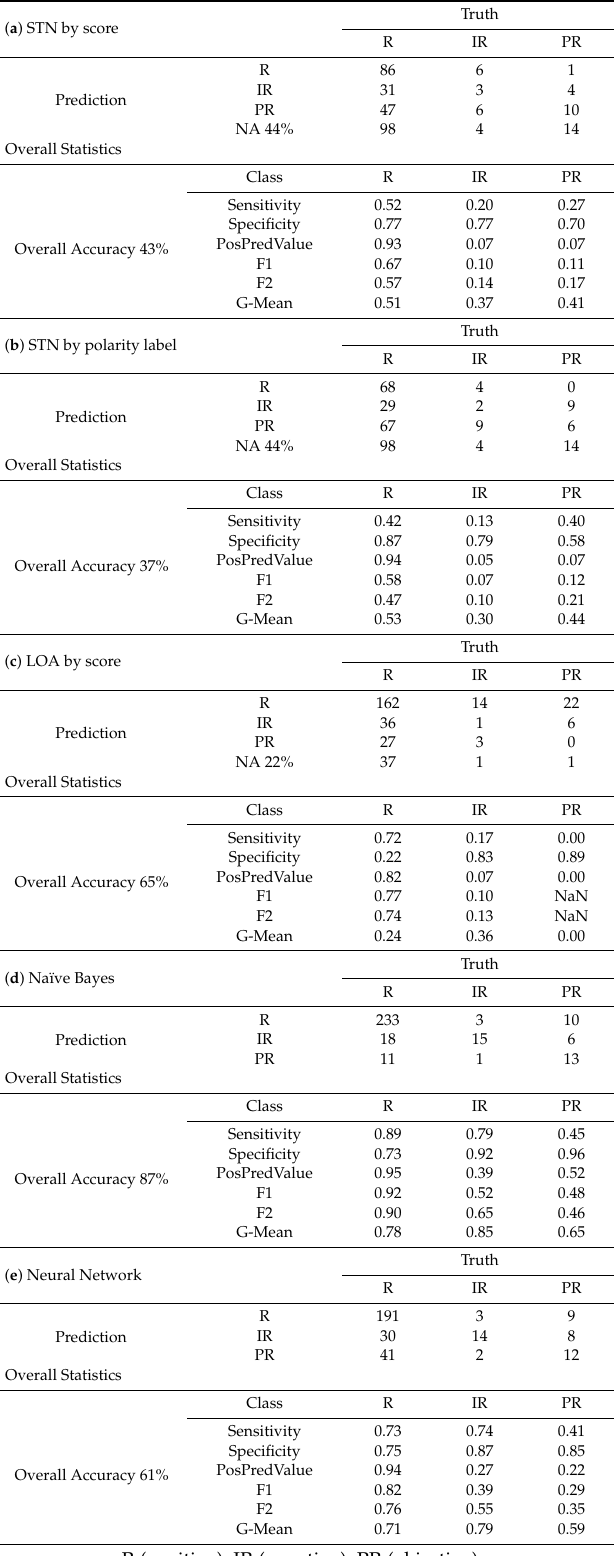
Table 4. The confusion matrices of fine-grained filtering processes over the Ataturk airport terror attack (ATA)